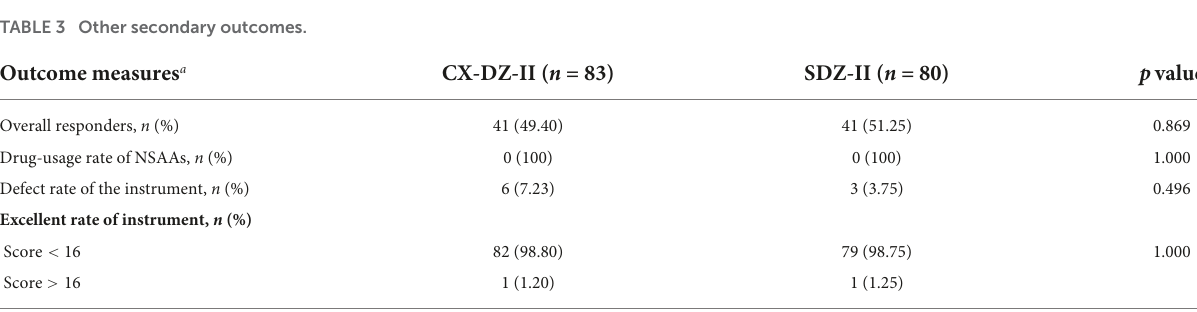
TABLE 3 Other secondary